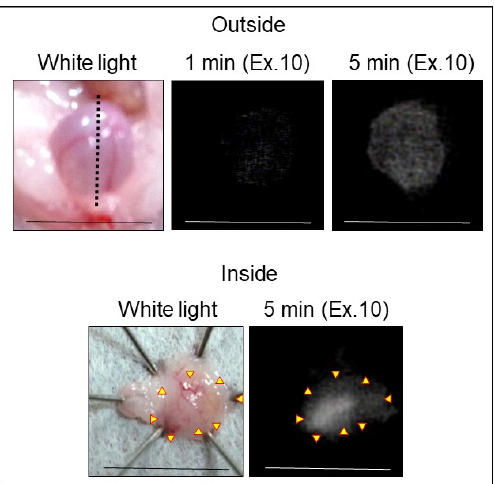
Figure 4. Representative near-infrared fluorescence (NIRF) imaging of MB49 bladder cancer with ASP5354. ASP5354 (2.4 μ M) was injected in cancerous bladder, 1 or 5 min after which, the cancerous bladder was rinsed with saline 5 times, filled up with saline, and NIRF imaging was performed. After imaging for 5-min incubation, the bladder was picked out and opened along the black dotted line. NIRF in the obtained bladder inner layer was imaged. NIRF is displayed in white. Scale bar represents 10 mm. Yellow arrows show points of boundary between NIRF and non-NIRF.